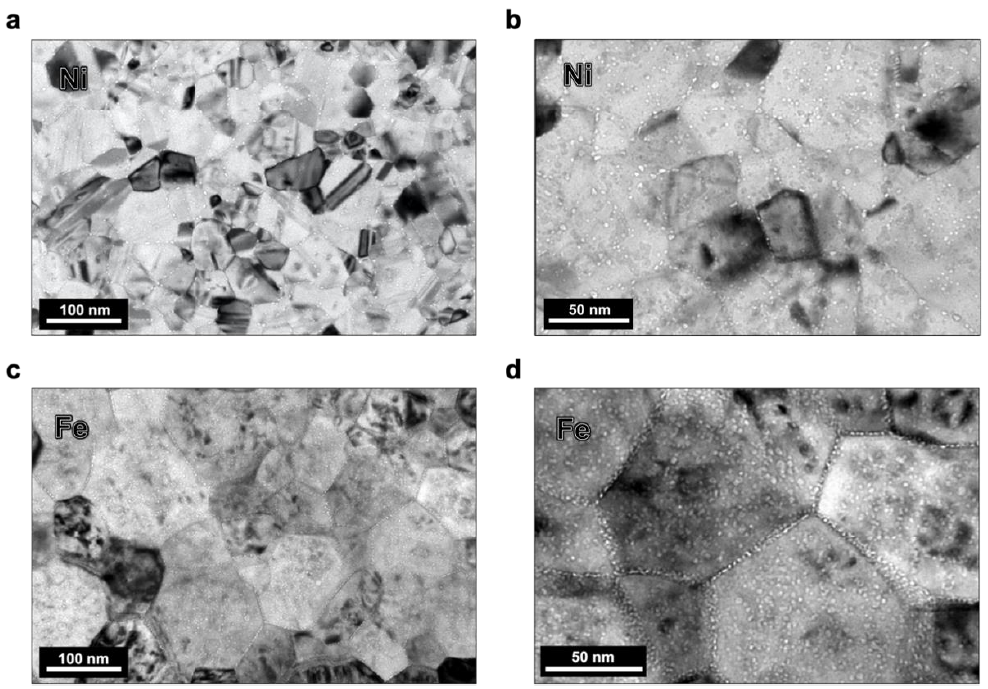
Figure 2. Under-focused bright field TEM images of regions in helium implanted ( a , b ) Ni and ( c , d ) Fe samples; bubbles are seen with white contrast decorating the grain interiors and GBs.